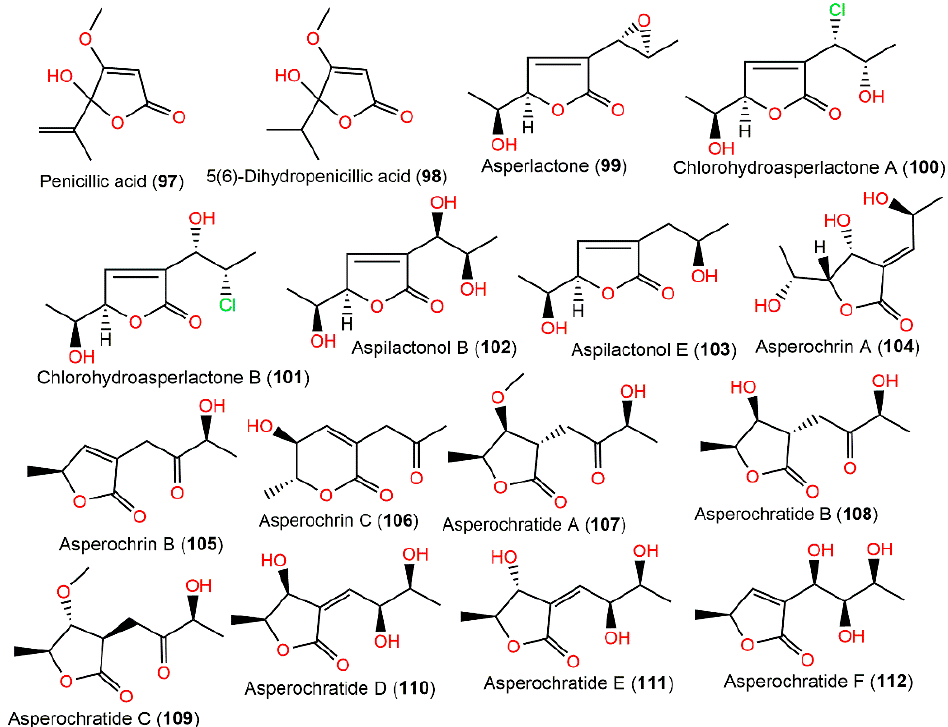
Figure 10. Polyketides ( 97 – 112 ) reported from A. ochraceus. The investigation of A. ochraceus MA15 obtained from marine mangrove Bruguiera gymnorrhiza rhizospheric soil resulted in three new metabolites: asperochrins A–C ( 104 – 106 ), along with the formerly separated 97 , 98 , 100 , 101 , and 118 – 121 . They were elucidated using NMR, CD, and Mosher’s methods. Compounds 104 and 105 featured α , β -unsaturated γ -lactone, while 106 had α , β -unsaturated δ -lactone moiety. They possessed no activity towards Artemia salina in the brine-shrimp lethality test. Meanwhile, 97 , 100 , 104 , 118 , and 119 revealed selective antibacterial potential (MIC ranged from 0.5 to 64.0 µ g/mL) versus V. harveyi , V. anguillarum , and A. hydrophilia , whereas 97 and 104 were the most powerful metabolites (MICs ranged from 0.5 to 32.0 µ g/mL). It was revealed that increased OH groups elevated activity and the terminal C-6(7) double bond (e.g., 97 vs. 98 ) was substantial for the activity [71]. Co-cultivation of A. ochraceus with Streptomyces lividans resulted in an increase in the yields of 97 and 98 ; however, its co-cultivation with B. subtilis yielded two new penicillic acid derivatives, ochraspergillic acids A ( 123 ) and B ( 124 ), which are new penicillic acid– aminobenzoic acid hybrids. Interestingly, it was suggested that the aminobenzoic acid moiety of 123 is originated by bacteria [17] (Figure